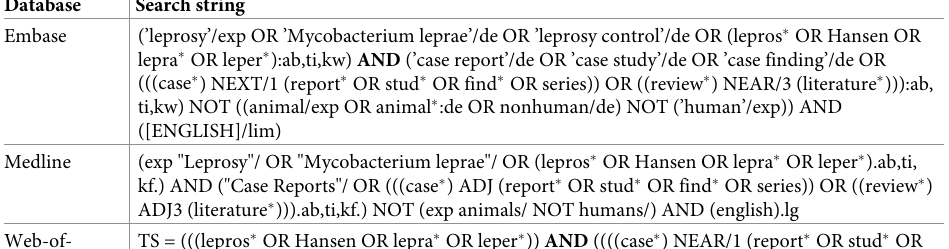
Table 1. Systematic review database and search strategy.